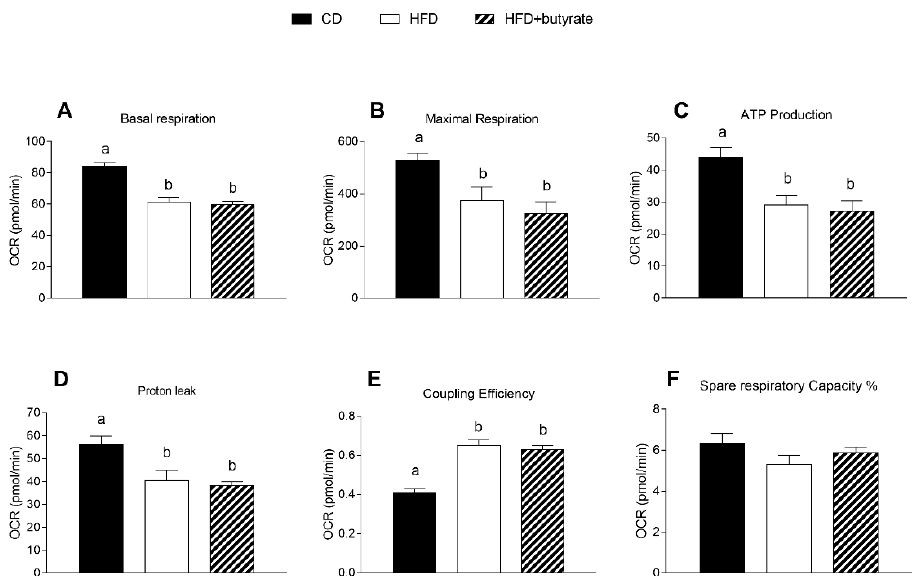
Figure 6. Effects of butyrate treatment on mitochondrial respiration parameters in the synaptosomal fraction in diet-induced obese mice: ( A ) basal respiration; ( B ) maximal respiration; ( C ) ATP production; ( D ) proton leak; ( E ) coupling efficiency and ( F ) spare respiratory capacity % are reported. Data are shown as means ± SEM from n = 6 animals/group. Different letters (a,b,c) on top of the bars indicate statistically significant differences ( p < 0.05) among groups.